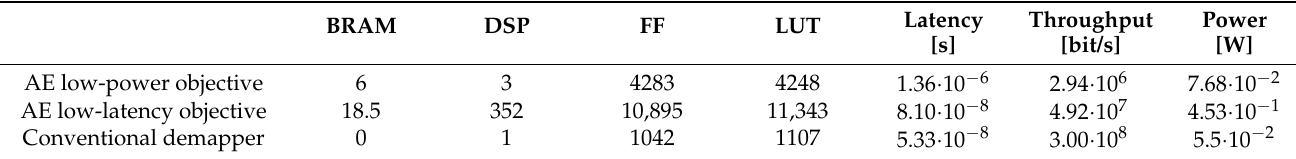
Table 2. Comparison of AE-based inference to conventional soft